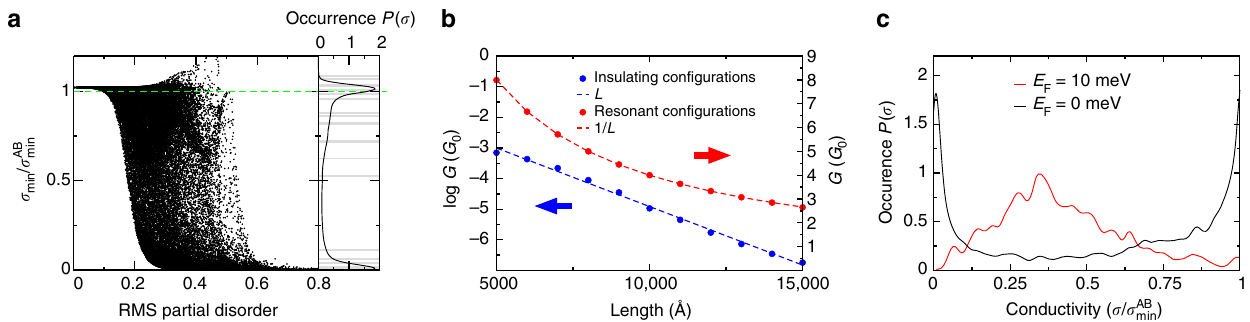
Fig. 3 Insulating and metallic behaviour in evanescent transport through disordered con fi gurations of partial dislocations. a For three partials, the minimal conductivity at the Dirac point is computed for an ensemble of randomly chosen partial positions, plotted vs. the RMS of the domain length distribution (cid:3) (cid:4) P 2 = L 2 of the partial con fi guration. Each dot represents one of 57,124 calculated realisations of the positions of three partial dislocations ¼ L 2 L i (cid:2) L i ¼ 1 ; 4 rms in a 1 μ m sample. All transport states between resonant and fully insulating may be seen, however minimal metallic conductivity (indicated by the dashed green line ) and fully insulating states are signi fi cantly more likely to be found than any other, as shown by the probability density function in the right hand panel . The grey bars represent experimental data 4 , which show a qualitatively similar likelihood of occurrence of transport states (each bar represents a transport measurement in one suspended bilayer graphene sample). b Conductance as a function of sample length: for a restricted ensemble average (cid:5) (cid:5) (cid:5) (cid:5) < 10 (cid:2) 3 ) a L − 1 dependence on length is seen, while for a restricted (cid:2) 1 over con fi gurations close to minimal metallic conductivity (de fi ned by σ min = σ AB (cid:5) (cid:5) (cid:3) (cid:4) min (cid:5) (cid:5) < 10 (cid:2) 3 ensemble average performed over the insulating con fi gurations σ min = σ AB the expected exponential decrease in conductivity with L is found min ( σ AB represents the minimal metallic conductivity of bilayer graphene). In c the probability density function for conductivity at the Dirac point is shown and min at a fi nite doping of 10 meV — only at the Dirac point is the two-state distribution function